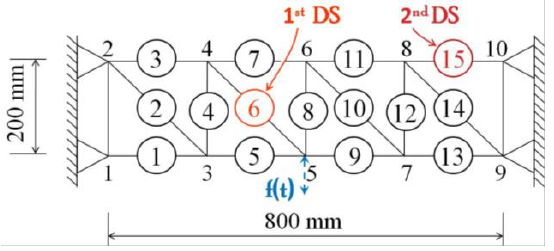
Figure 4. Experimental steel truss model with monitored member and damage